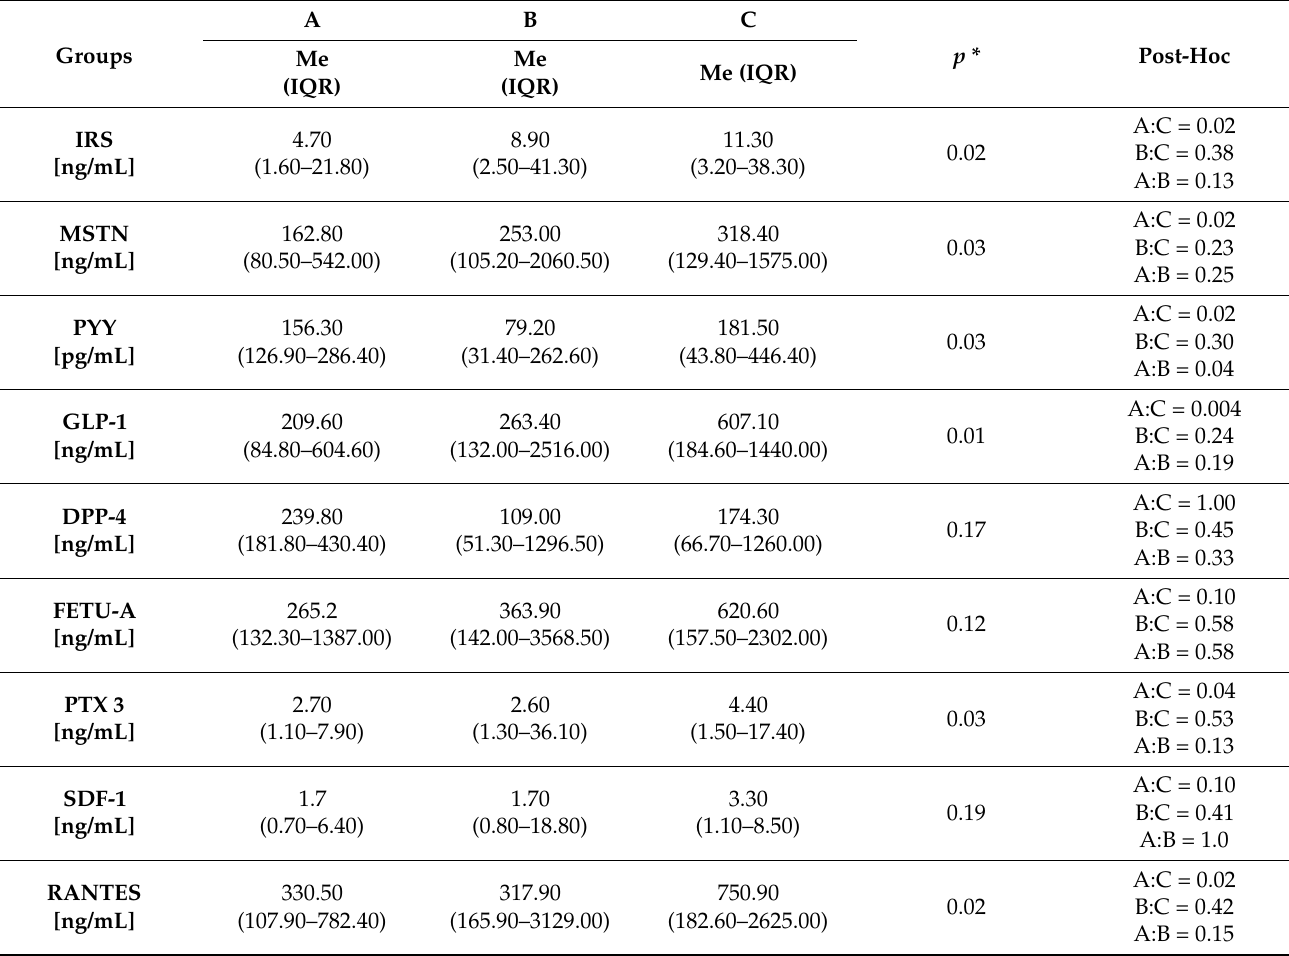
Table 3. Results for selected parameters in the plasma of HIV-infected men before (A) and after cART (B) and in the control group (C) with statistical